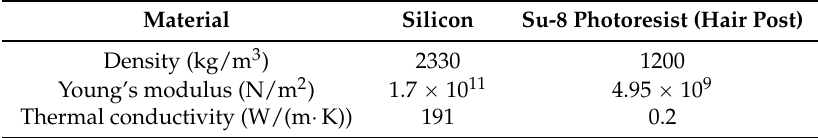
Table 2. Material properties of the hair structure.